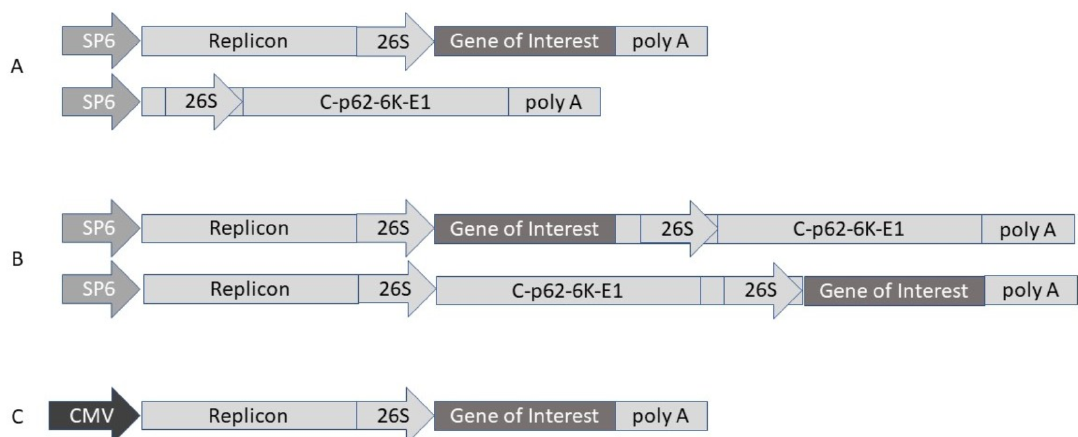
Figure 5. Alphavirus expression vectors. ( A ) Replication-deficient alphavirus system with expression vector (above) and helper vector (below). ( B ) Replication-proficient alphavirus system including two alternative insertion sites. ( C ) DNA/RNA layered Semliki Forest virus (SFV) vector. 26S, SFV 26S subgenomic promoter; CMV, cytomegalovirus promoter; Poly A, polyadenylation signal; Replicon, replicase (non-structural genes); SP6, SP6 RNA polymerase